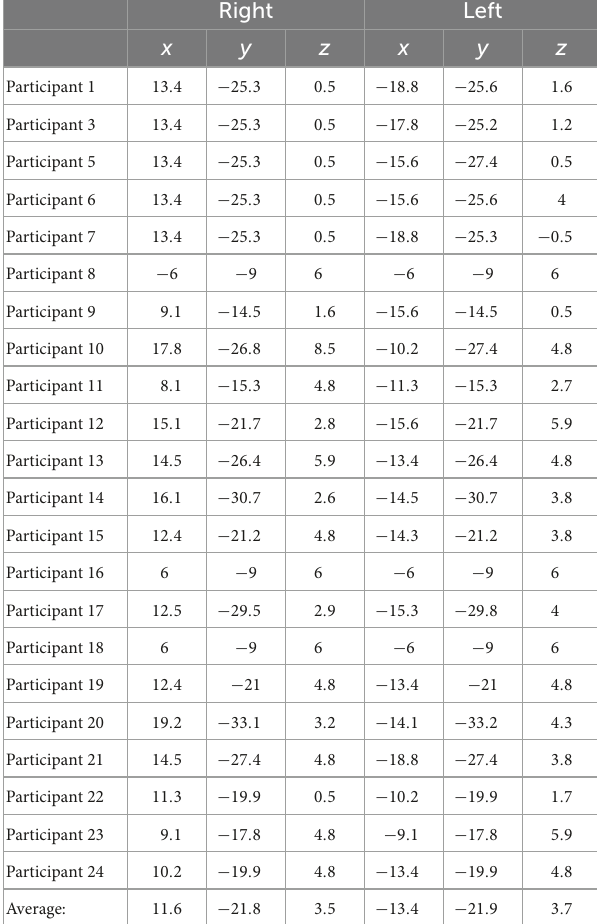
max t -value 3.052, latency at max 170 ms, load 2 mean 26.248 nAm, load 5 mean − 1.746 nAm, Figure 5B ) between 160 and 390 ms. The right thalamus source also showed greater amplitude during low compared to high load in four separate time windows. The earliest window of significant difference was between 240 and 330 ms ( p = 0.022, max t -value 3.679, latency at max 290 ms, load 2 mean 32.518 nAm, load 5 mean 2.919 nAm Figure 5C , first red vertical shade) followed by time intervals between 506 and 582 ms ( p = 0.034, max t -value 3.314, latency at max 538 ms, load 2 mean 16.831 nAm, load 5 mean − 6.520 nAm, Figure 5C , 2nd red vertical shade), 694 and 760 ms ( p = 0.046, max t -value 2.808, latency at max 726 ms, load 2 mean 8.727 nAm, load 5 mean − 9.242 nAm, Figure 5C , 3rd red vertical shade), and 858–956 ms ( p = 0.021, max t -value 3.491, latency at max 914 ms, load 2 mean 11.564 nAm, load 5 mean − 0.561 nAm Figure 5C , 4th red vertical shade). Functional magnetic resonance imaging-weighted sources in left and right parahippocampus ( Supplementary Figure 7a ) showed similar evoked response amplitude during the low and high load encoding periods with no significant differences between load ( p = 0.486, max t -value 2.357, latency at max 86 ms, load 2 mean 31.071 nAm, load 5 mean 18.205 nAm) at any time period in left or right hemisphere ( Supplementary Figures 7b,c